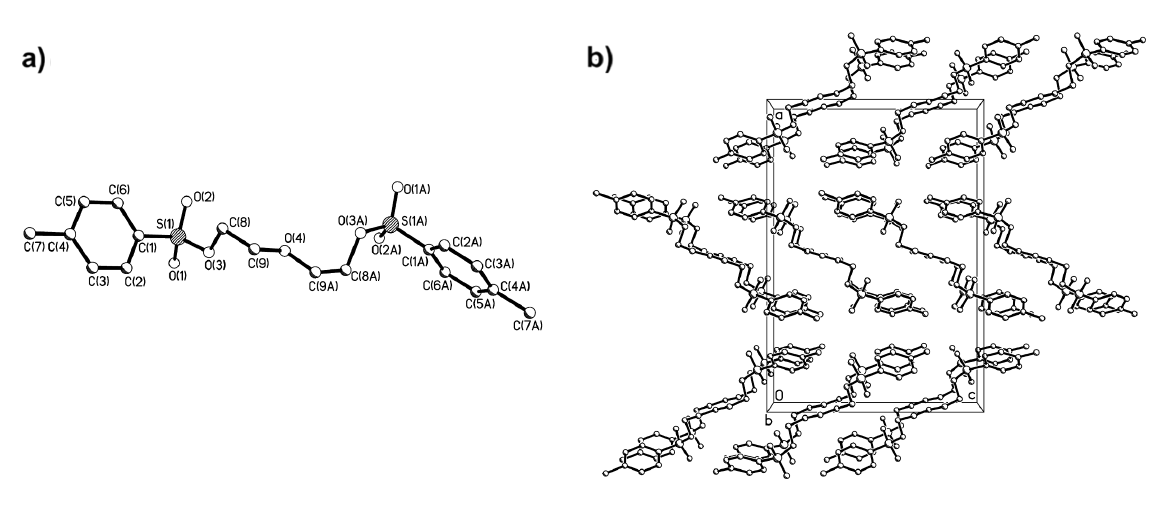
Figure 3: Molecular structure a) and packing diagram b) of the structure of diethyleneglyclol ditosylate (DiTos-A).